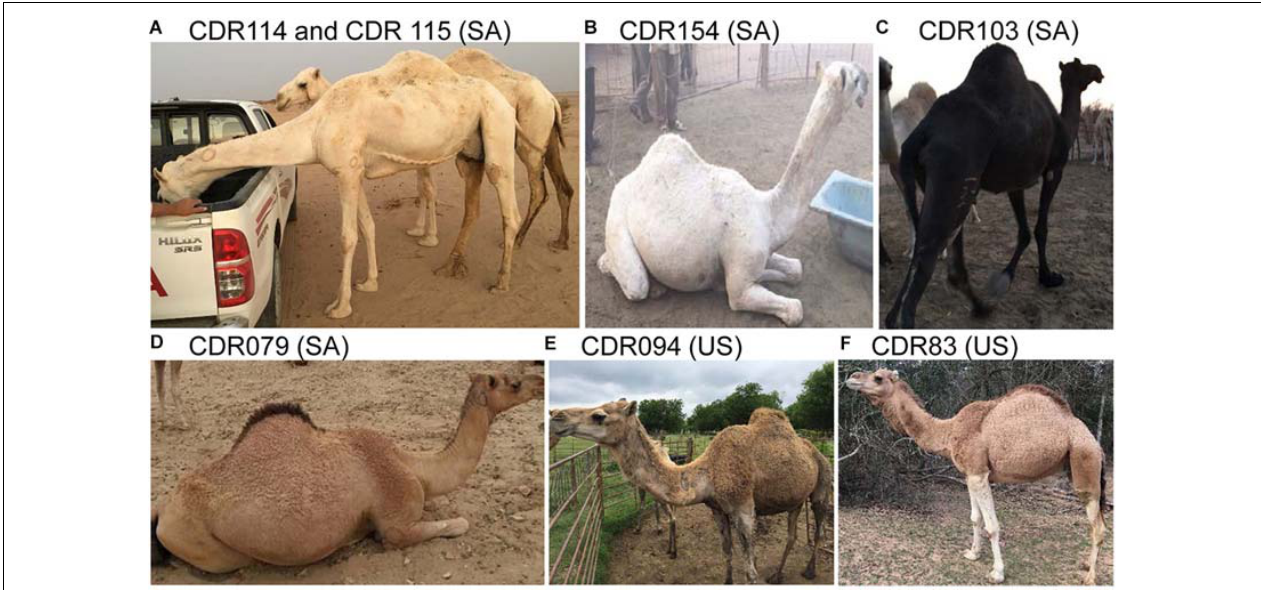
FIGURE 1 | Examples of animals and coat colors used for this study. (A) White/cream; (B) White; (C) Black; (D) Reddish brown with dark hump and tail; (E) Medium brown; and (F) Light brown; SA, Saudi Arabia; US, United States; dromedary IDs and genotypes are in Supplementary Table S1